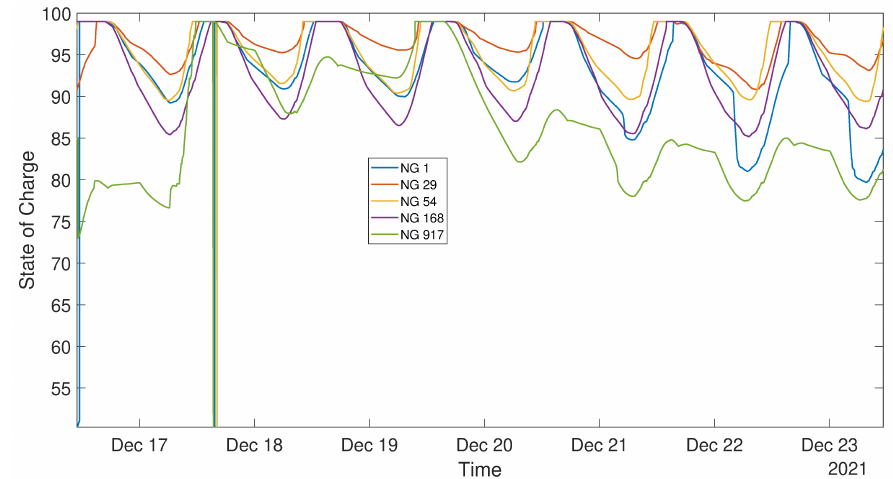
Figure 31. Evolution of the measured SoCs of the interconnected NGs.